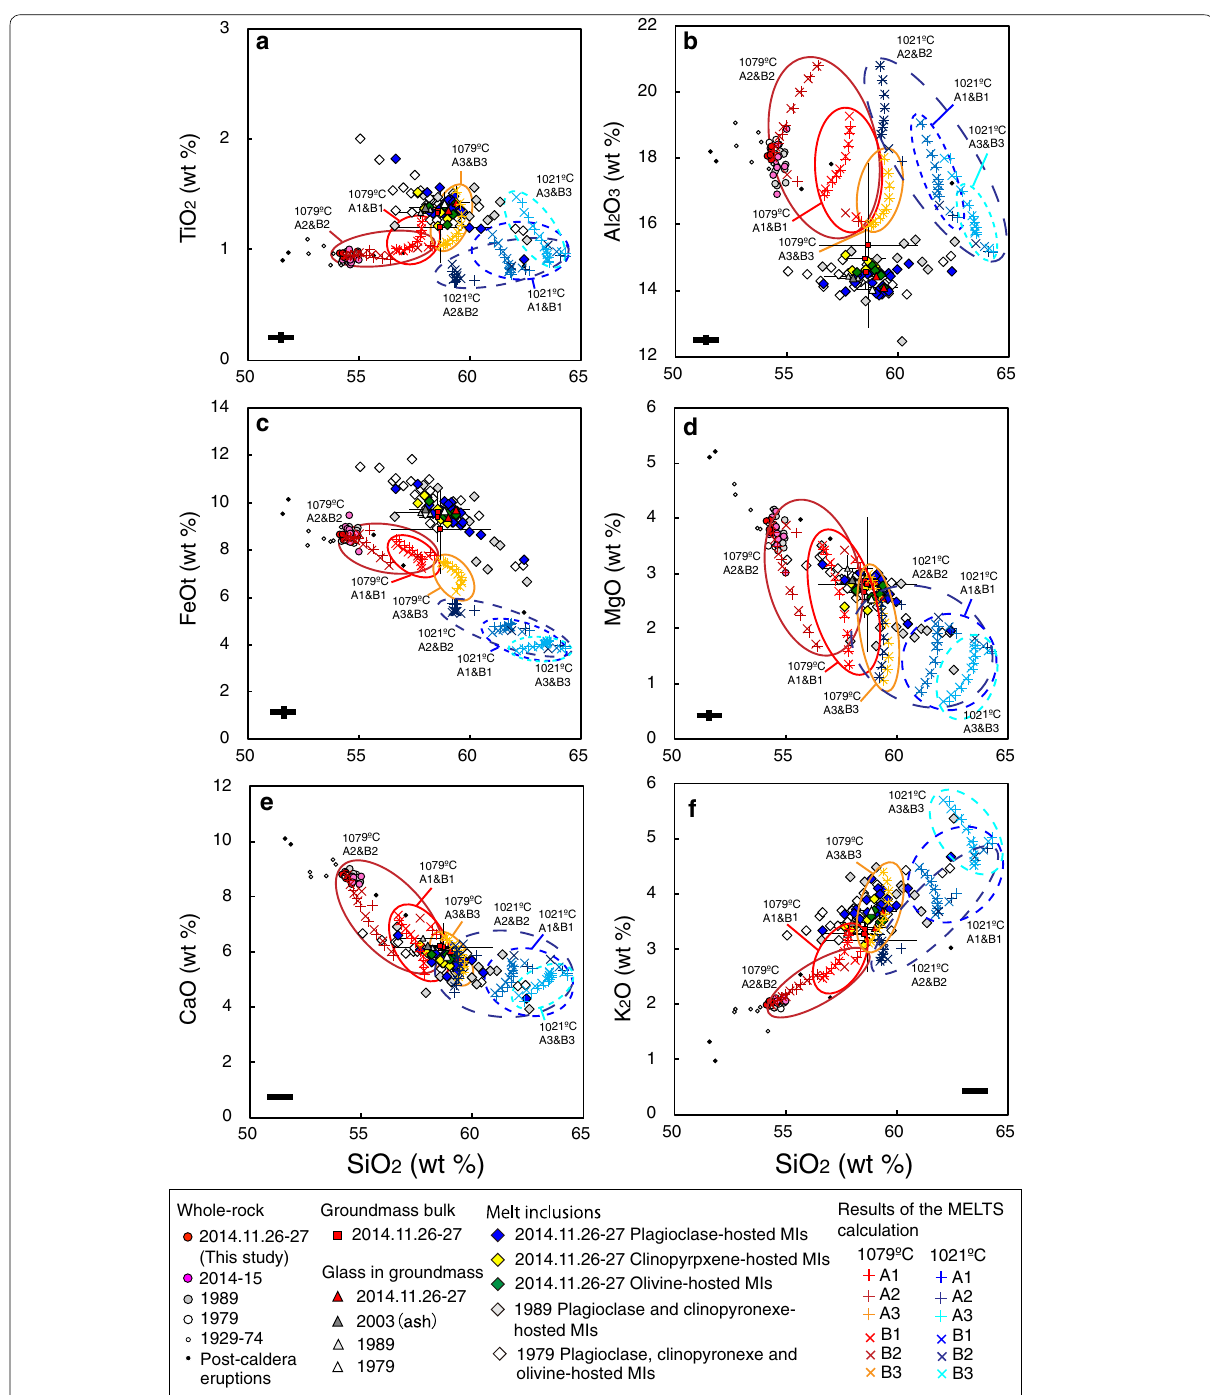
Fig. 2 The results of the major-element composition analysis of the eruptive products of the 1979–2014 eruptions. The major-element compositions of the whole-rock January 26–27, 2014, scoria, groundmass in the 1979, 1989, and 2014 scoria, and 2003 ash particles, and melt inclusions in the 1979, 1989, and 2014 scoria are shown. The analytical errors of the EPMA measurement (Saito et al. 2010) are shown as black bars in the lower part of each graph. The chemical compositions of the melt calculated from the whole-rock composition of I141129S01 using the MELTS program (Table 5; Additional file 3: Table S2) are also shown as cross symbols (see text). The whole-rock composition of the scoria erupted from 1929 to 1974 and from June to November 1979 (GSJ and Kumamoto Univ 1990; Ono and Watanabe 1985), scoria from October 1989 to November 1990 (GSJ and Kumamoto Univ 1990; Aso Volcano Museum et al. 1991), and scoria from November 2014 to March 2015 (NIED et al. 2015a, b) are also